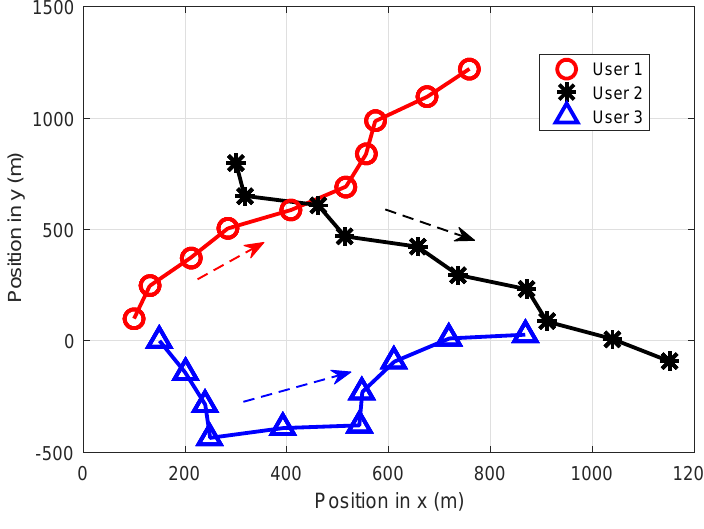
Figure 5. The trajectory setting for UAVs.